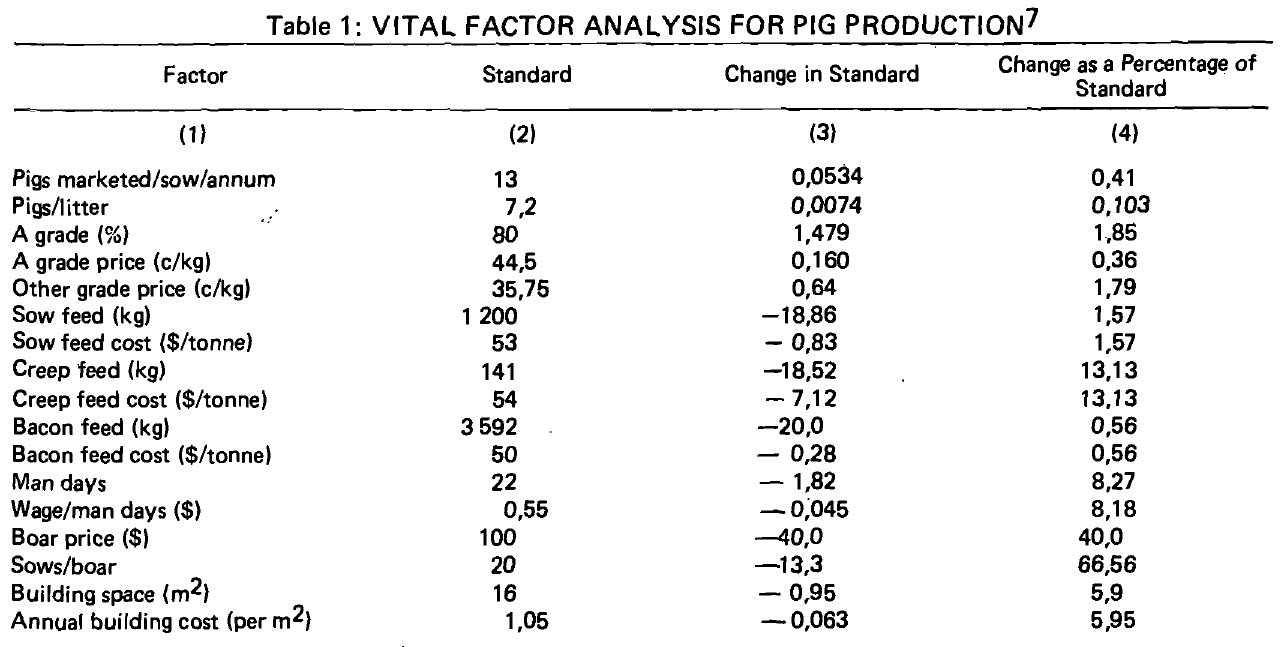
Table 1: VITAL FACTOR ANALYSIS FOR PIG PRODUCTION7